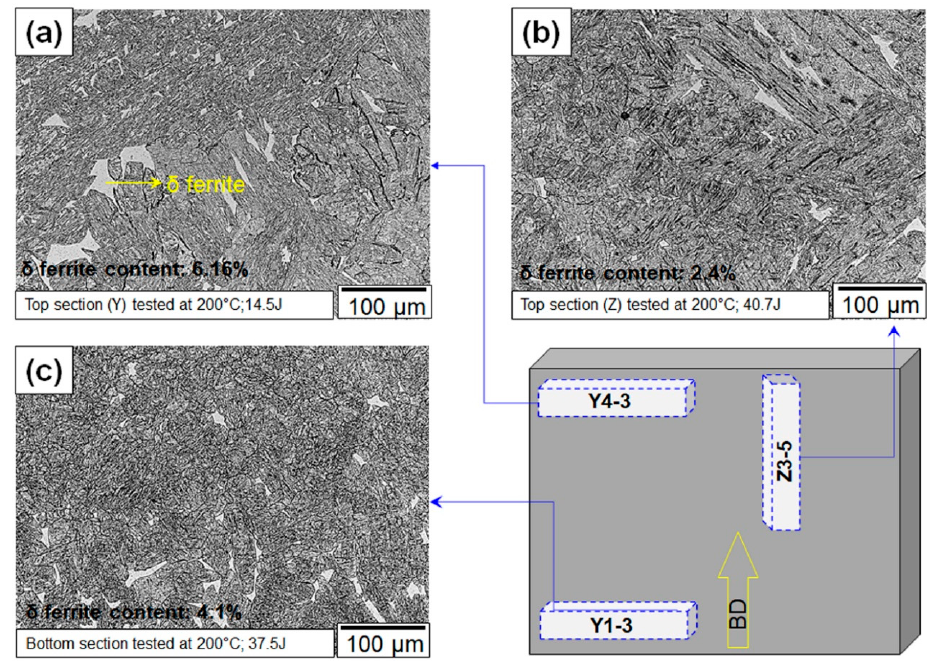
Figure 5. Representative microstructural observation on failed Charpy samples sectioned ( a , c ) perpendicular and ( b ) parallel to build direction from different build heights.